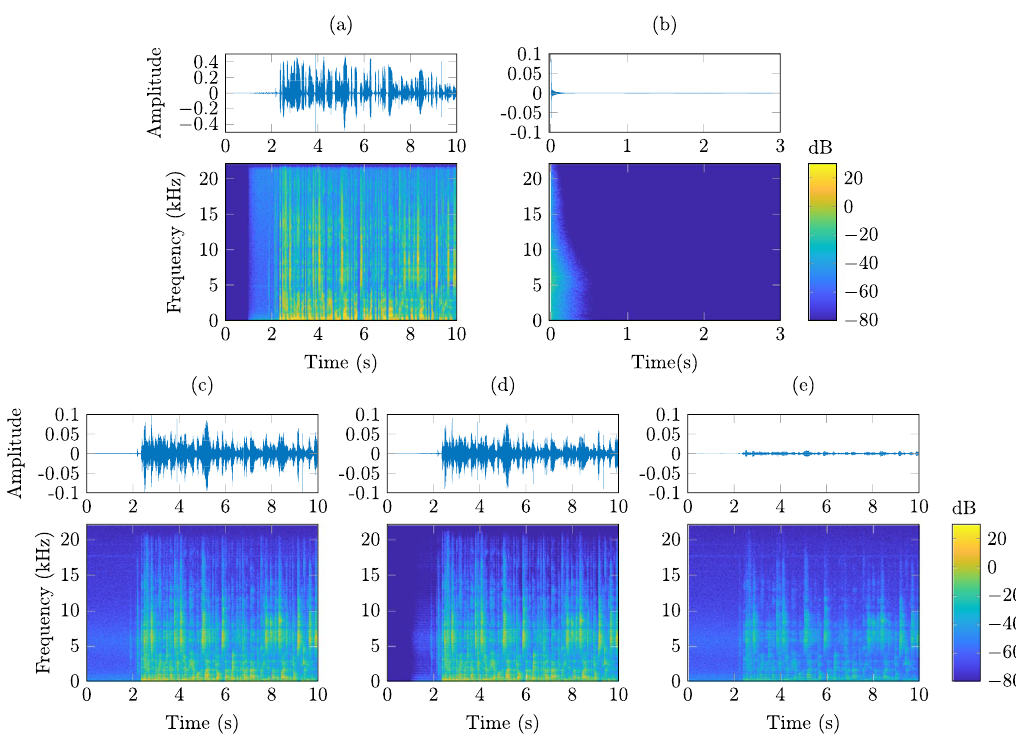
Fig. 10 Waveform and corresponding spectrogram of signals related to the AIL recordings. a First 10 seconds of the source signal corresponding to a female speaker, F1 (cf. Table 3), b computed RIR from the loudspeaker SL5_1 to microphone BTELF (cf. Fig. 3), c recorded microphone BTELF signal after the signal from a was played through the loudspeaker SL5_1, d simulated signal from the convolution of a and b , e error between signals c and d